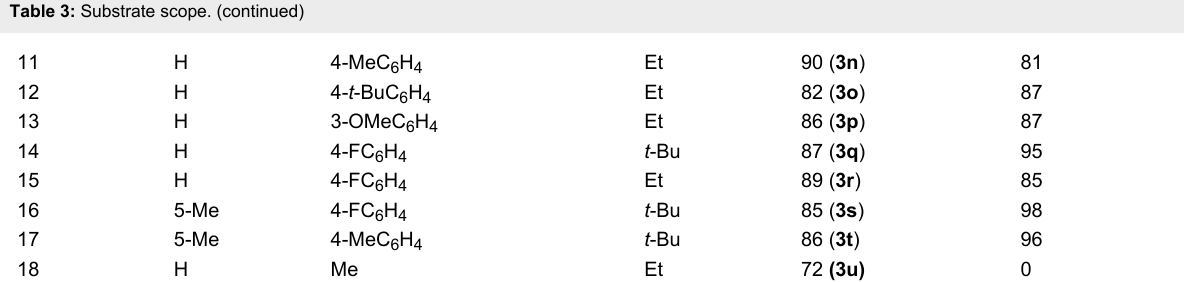
the 3-substituent was changed to an alkyl group (Table 3, entry 18).